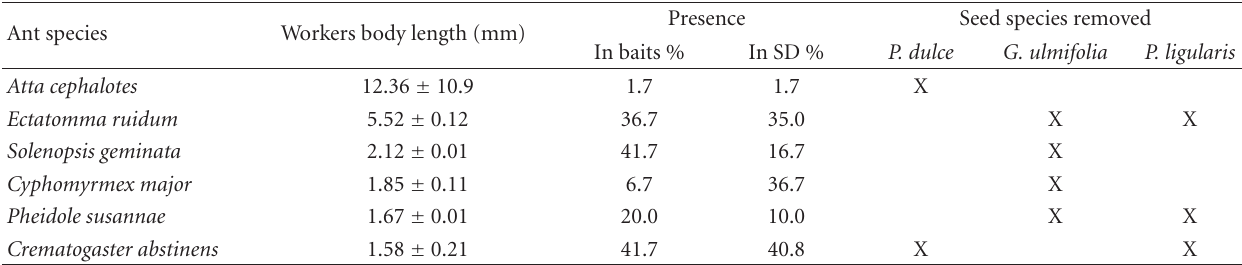
Table 4: Description of ant species carrying seeds. Body length of workers and its incidence in baits and seed depots (SDs) were recorded, as the seed species they removed. The body length of workers was measured from the posterior margin of clypeus to the posterior end of the last petiole.